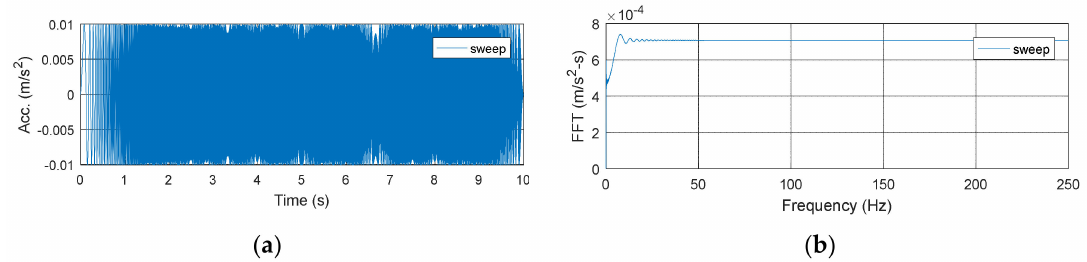
Figure 11. Sinusoidal sweep wave and its fast Fourier transform (FFT): ( a ) Sweep wave; ( b ) FFT.